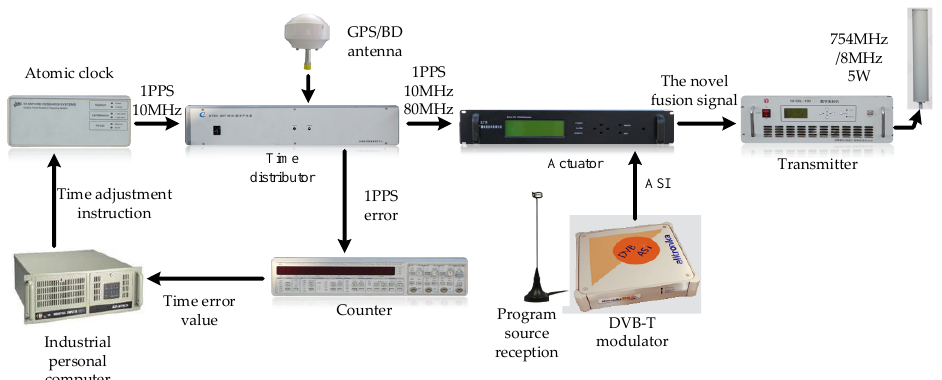
Figure 15. Each equipment of the modified base station.